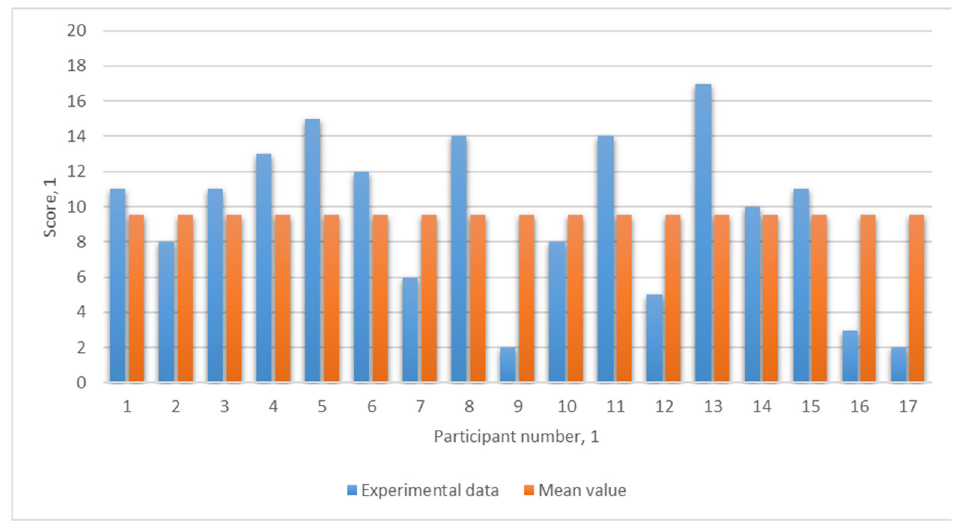
Figure A1. An example of the experimental data: active 2R spherical mechanism-based joint, velocity control mode, task 2. Experimental data shown in blue, mean values shown in orange.